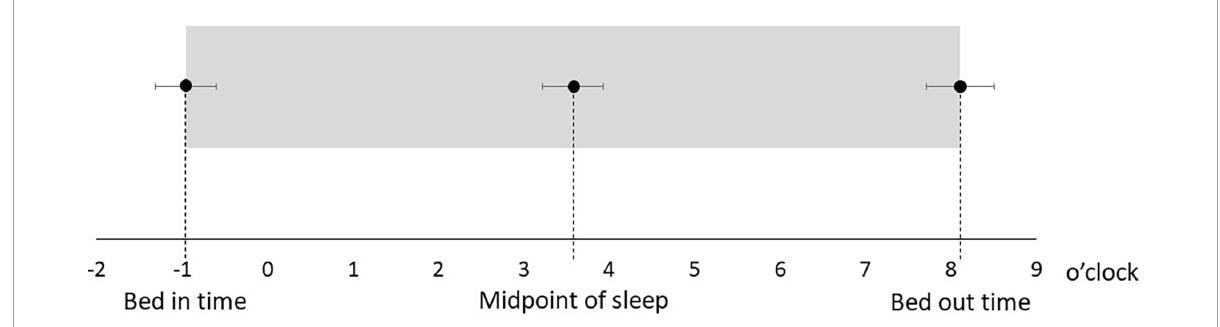
FIGURE1 Actual sleep-wake schedule.